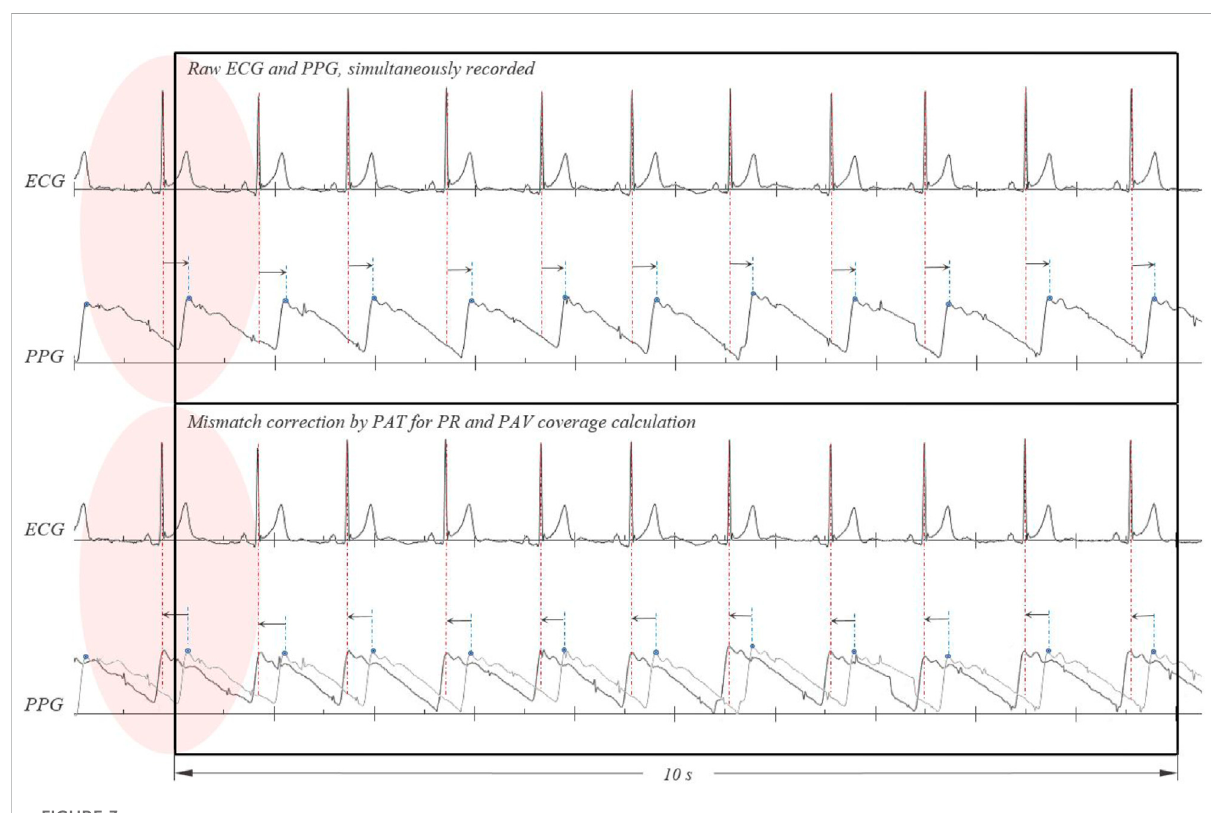
FIGURE 3 Correction of the mismatch in the PPG signal for the calculation of PR and PAV coverage. Before calculating the coverage of the series referenced in the PPG pulses, such as PR or PAV, the average PAT must fi rst be subtracted to align the occurrence of the pulses ( n FP i ) with